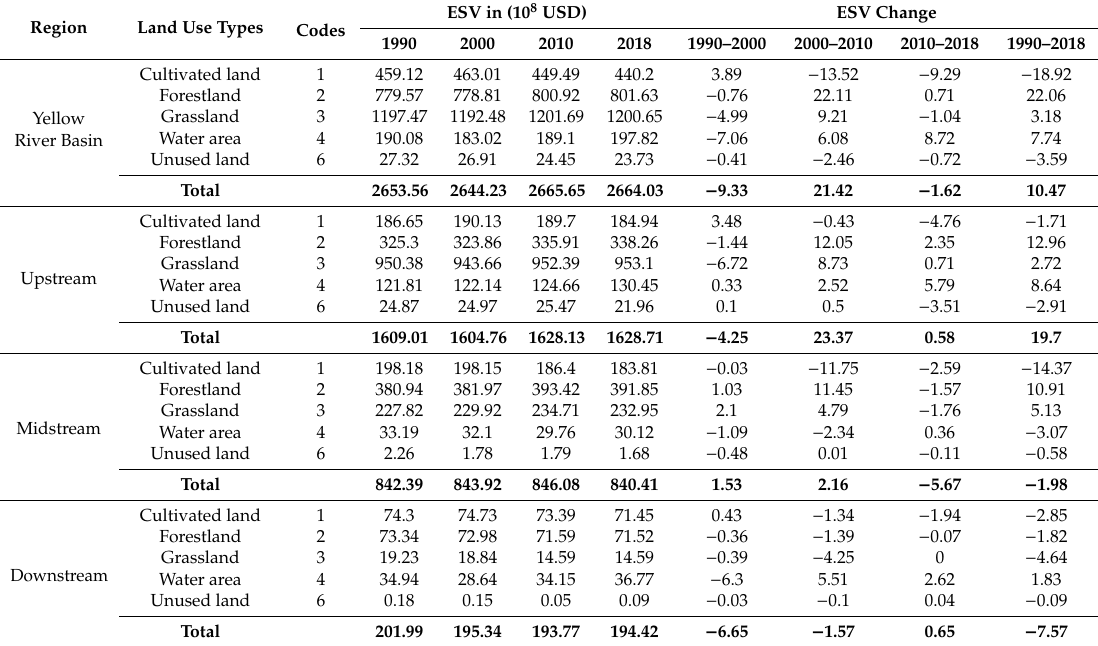
Table 4. Changes in total ESV from 1990 to 2018 ( × 10 8